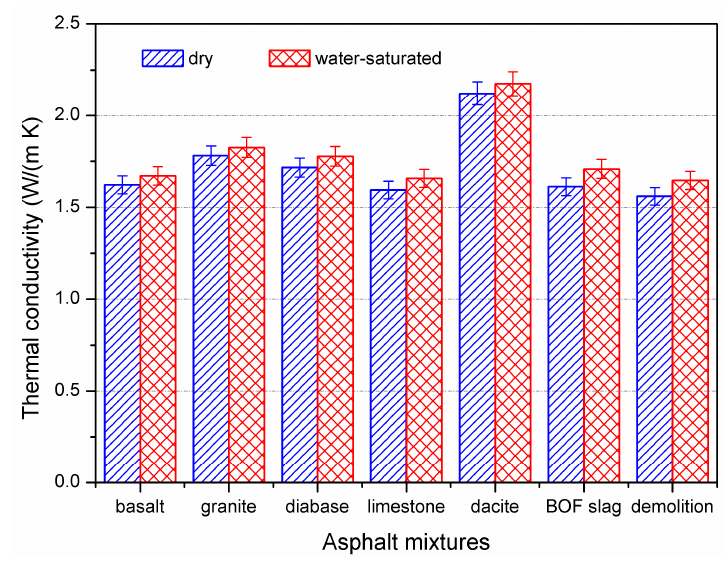
Figure 6. Thermal conductivity of dry and water-saturated asphalt mixtures.